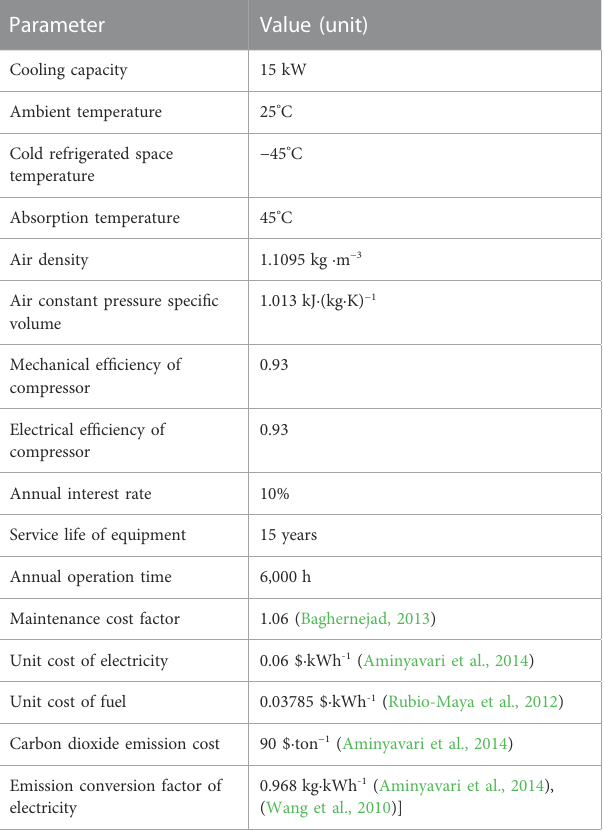
TABLE 5 Input values of the constant modeling parameters.